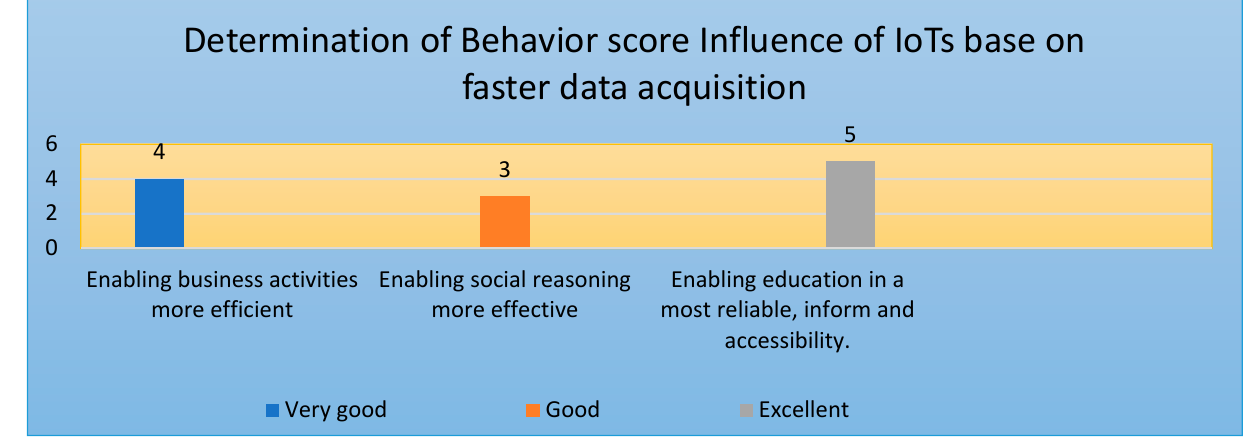
Figure 7. Behavior score influence graph of fast data collection.